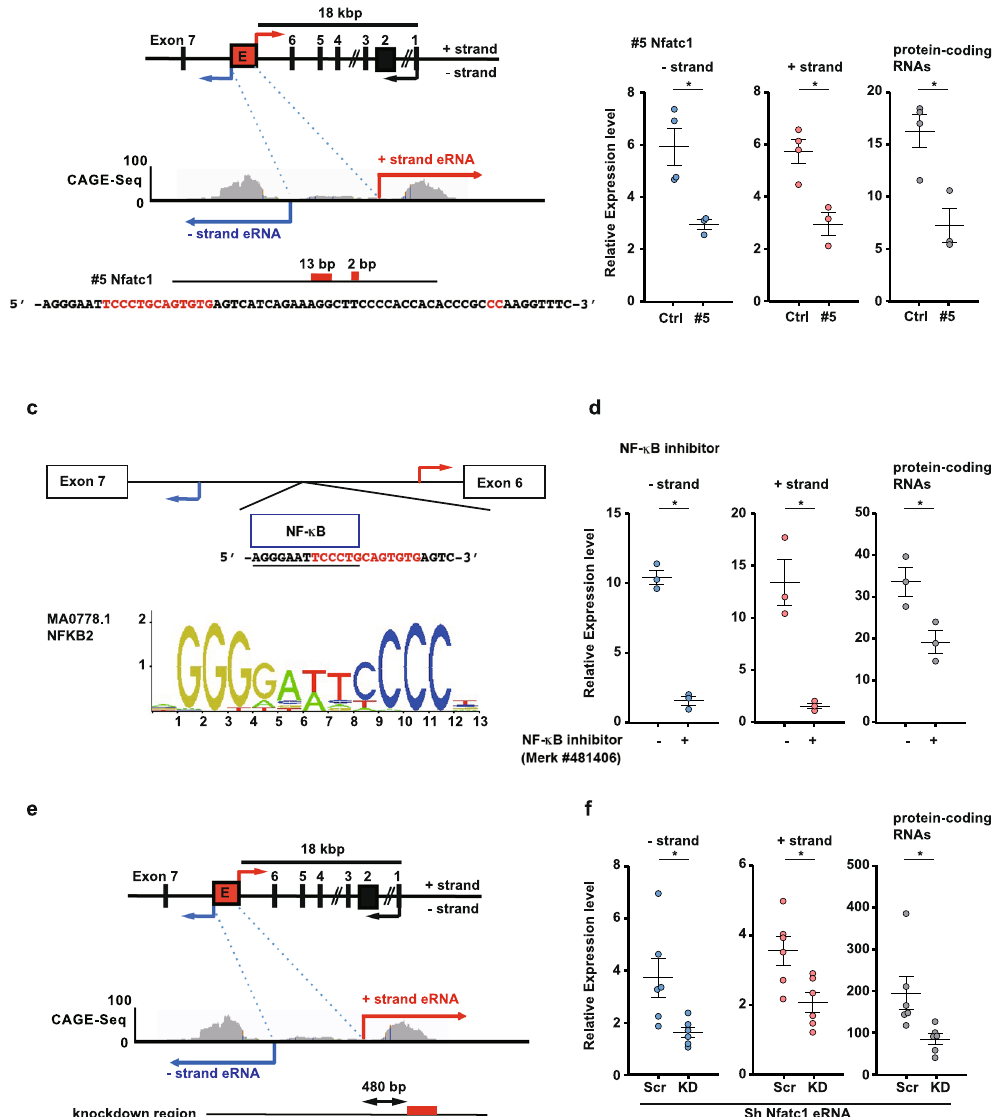
Figure 4. The effect of intronic putative eRNAs on Nfatc1 protein-coding RNA expression. ( a ) The effect of deletions in the intronic putative eRNA region of Nfatc1 using CRISPR/Cas9. Schematic diagram of the genomic locus and the deleted regions (deletions are marked with red letters) in RAW 264.7 cells. ( b ) qRT-PCR analysis of the relative expression levels of protein-coding RNAs as well as the − and + strand eRNAs following RANKL stimulation. Data are the mean ± SEM; n = 3–4 biological replicates with 3–4 technical replicates each. Ctrl cells were transfected with the scrambled sequence shown in Supplementary Table S3. ( c ) Motif analyses of the deleted eRNA region. The high score motif (NF- κ B) of the deleted sequence was analysed using JASPAR. (d) The effect of the NF- κ B inhibitor (Merck #481406) on eRNA levels in RAW 264.7 cells. Data are the mean ± SEM; n = 3 biological replicates with 3–4 technical replicates each. (e) Suppression of the + strand eRNA by small hairpin (shRNA) transfection. Schematic of the genomic locus with the CAGE profile and the deleted regions in monocyte-macrophage precursor cells (BMMs). ( f ) qRT-PCR analysis of the relative expression levels of protein-coding RNAs, as well as the − and + strand eRNAs following RANKL stimulation in shRNA-transfected BMMs. Analyses were performed on total RNAs. Data denote the mean ± SEM; n = 6 biological replicates with 3–4 technical replicates each. * P < 0.05; NS, not significant [Student’s t -test for ( b ) and ( d ); Dunnett’s test for (f)